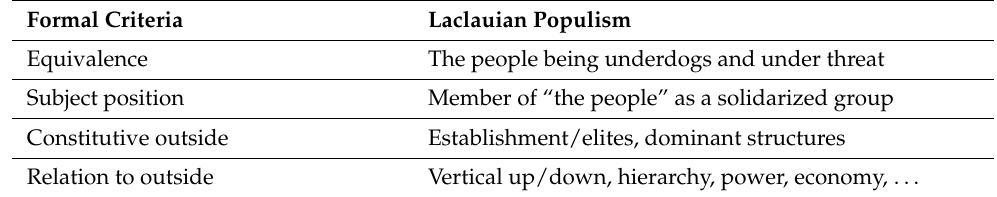
Table 1. Conceptualization of populism’s logic following Laclau’s